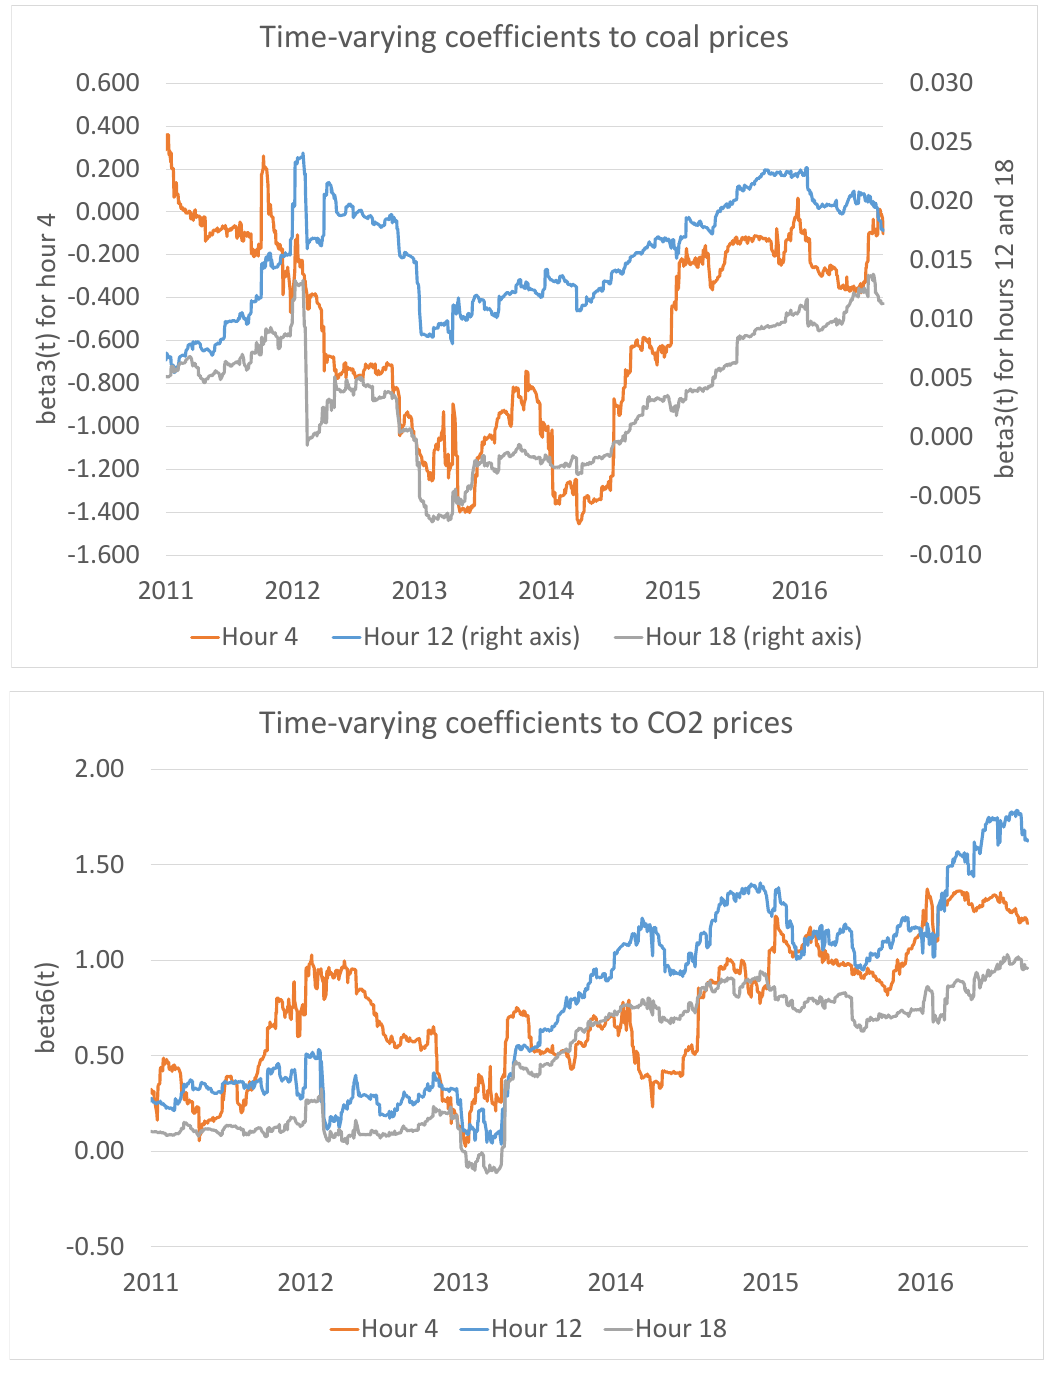
Figure 6. Time-varying coefficients of coal and CO 2 prices. The coefficients have been estimated for the sample period from 1 January 2011 until 31 August 2016 with respect to the key hours H4, H12 and H18 on working days. Note that in the upper graph values for H12 and H18 are scaled on the right